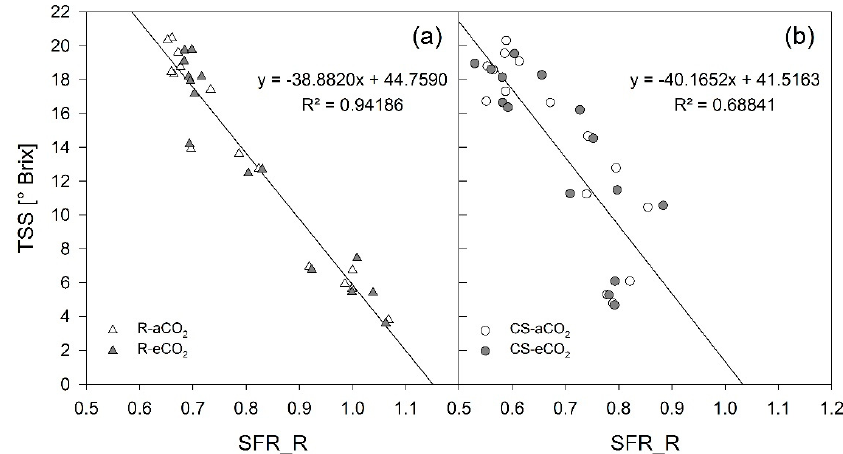
Figure 5. Relationship between SFR_R and total soluble solids (TSS) in Riesling ( a ) and Cabernet Sauvignon ( b ) berries of the two treatments aCO 2 and eCO 2 .